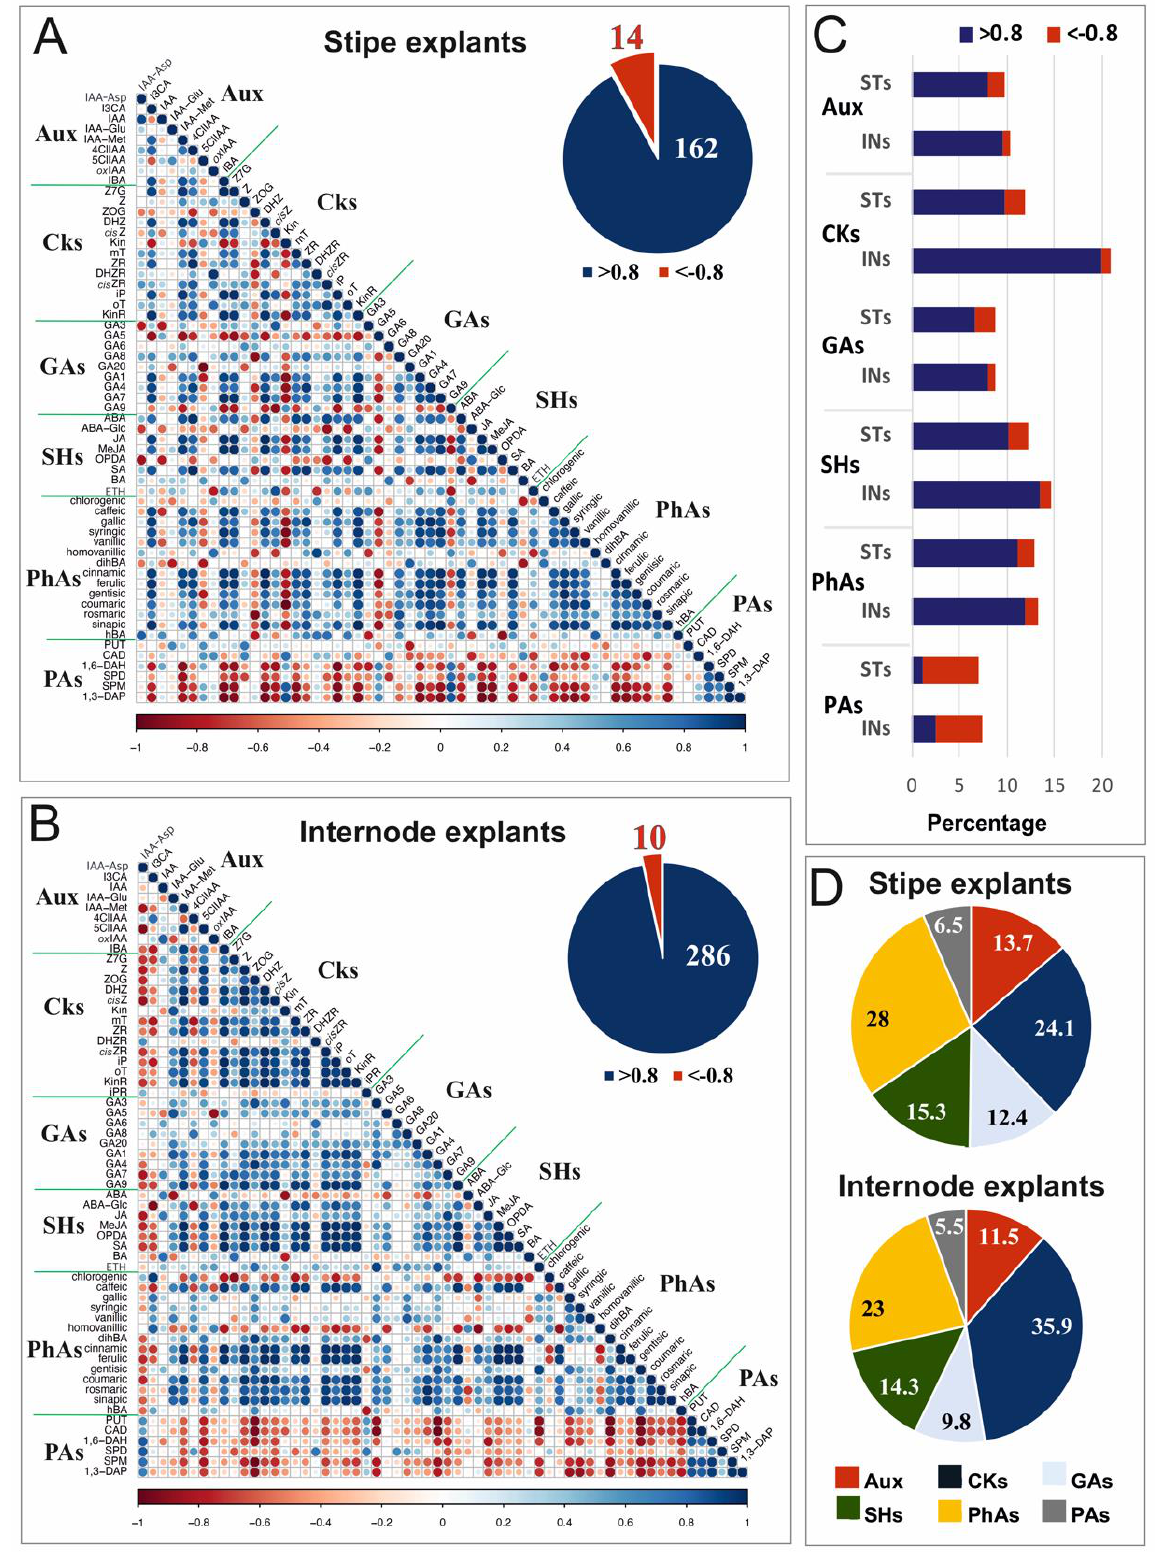
Figure 7. Pearson correlation matrix of the recorded relationships between contents of selected endogenous compounds in stipe ( A ) and internode ( B ) explants ( n = 6), and quantitative comparison of correlations recorded between them as a result of the Pearson’s correlation matrix analysis, with r > 0.8 and r < − 0.8 ( C , D ). ( A , B ) The degree of pairwise correlation with respect to the Pearson correlation coefficients is displayed by the color gradient. Positive correlations are displayed in